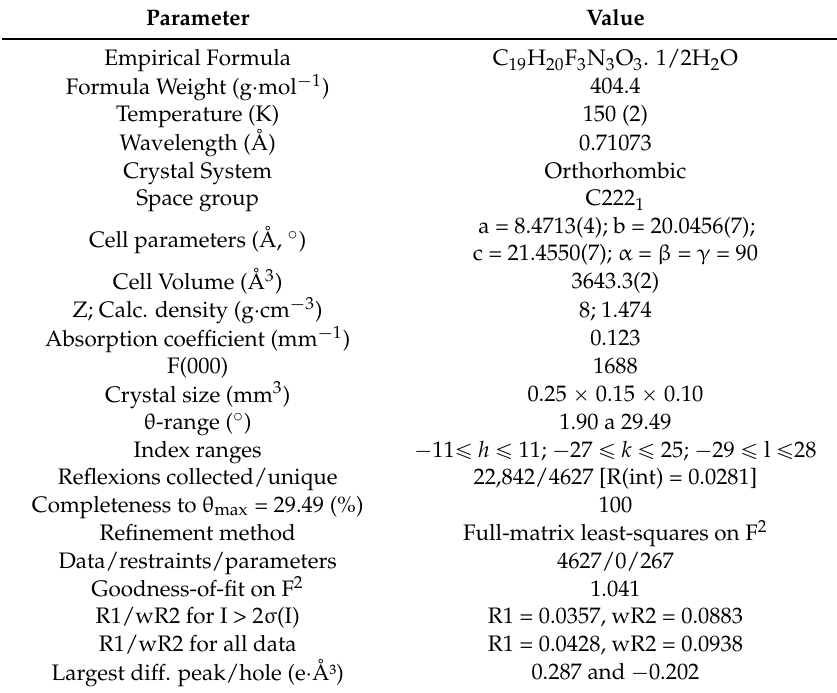
Table 1. Crystal data and the structures refinement for ORBI hemihydrate